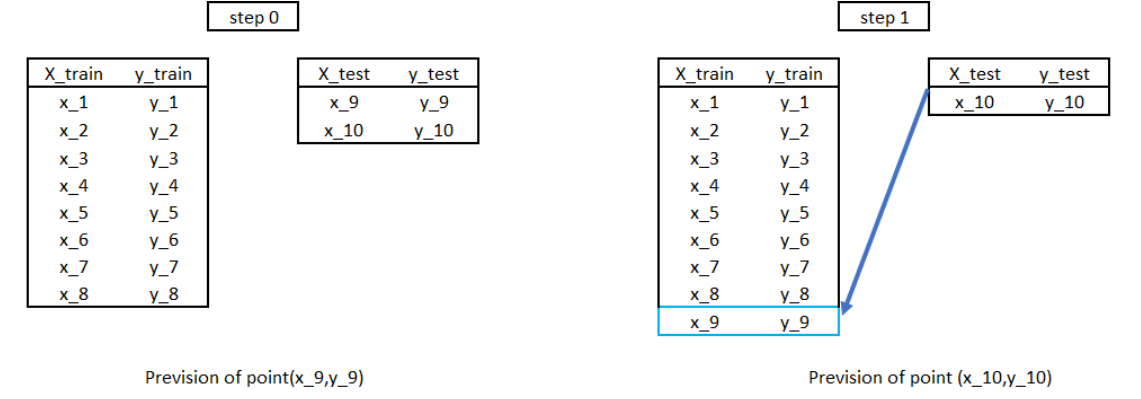
Figure 3. Example of